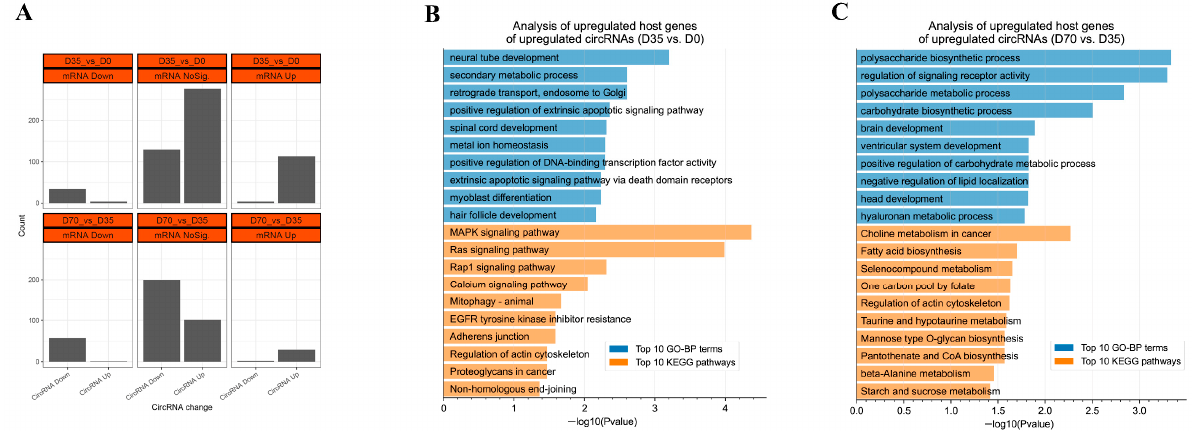
Figure 5. Expression relationships between circRNAs and their hose genes and functional annotation of upregulated circRNAs transcribed from upregulated host genes. ( A ) Classification of DECs based on the expression relationships between circRNAs and hose genes. ( B ) GO enrichment and KEGG analysis of upregulated DEmRNAs with upregulated DECs from D0 to D35. ( C ) GO enrichment and KEGG analysis of upregulated DEmRNAs with upregulated DECs from D35 to D70.